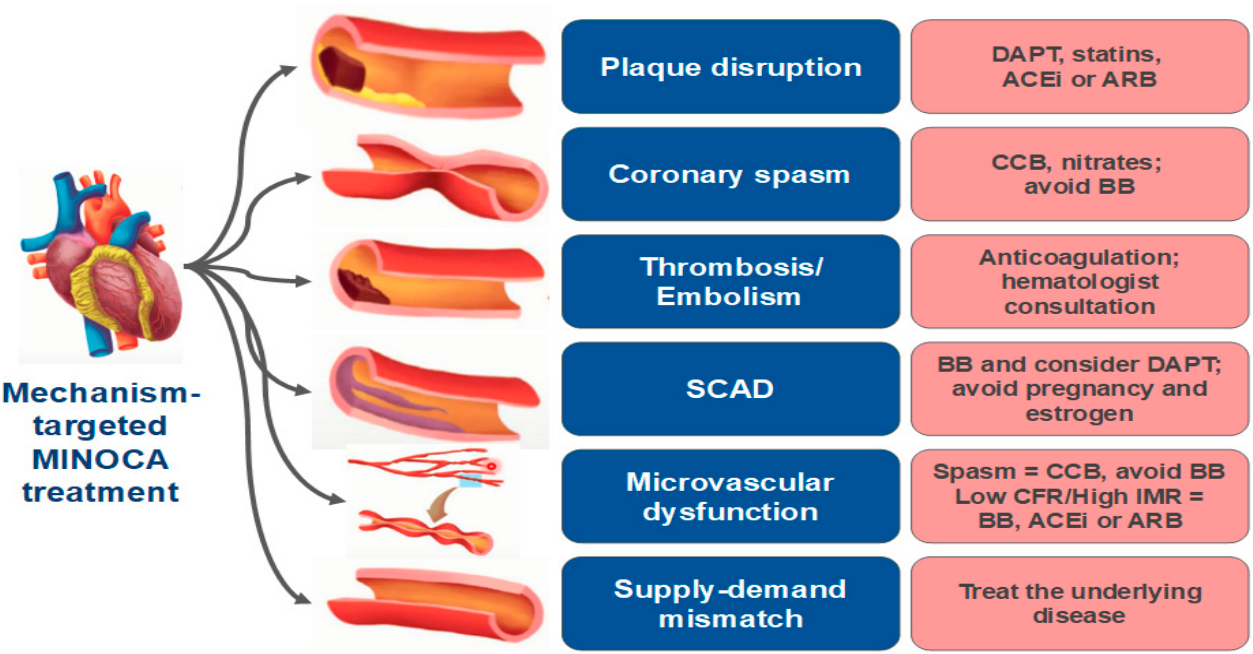
Figure 14. Mechanism-targeted MINOCA treatment. ACEi = angiotensin-converting enzyme in- hibitor; ARB = angiotensin receptor blockers; BB beta-blocker; CCB = calcium channel blocker; CFR = coronary flow reserve; DAPT = dual antiplatelet therapy; MINOCA = myocardial infarction with non-obstructive coronary arteries; IMR = microvascular resistance indices; SCAD = spontaneous coronary artery dissection.